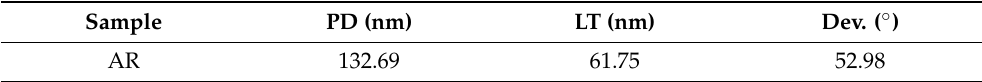
Table 1. Quantitative analysis of the microstructures: average particle diameter (PD), average lamellae thickness (LT) and preferred deviation in relation to RD